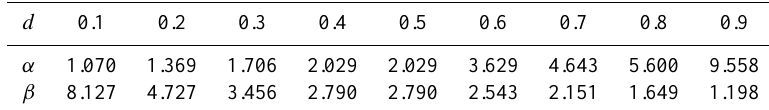
Table 4. Parameter estimation of the Beta distribution.